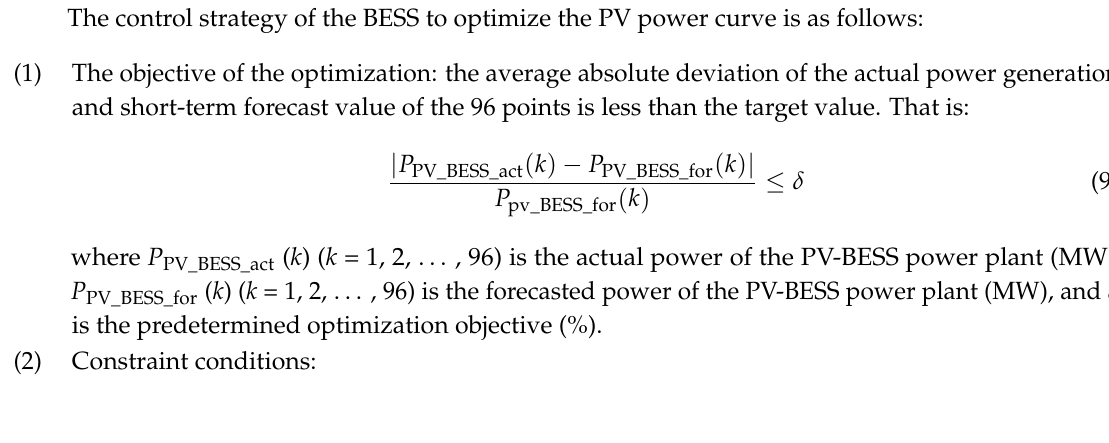
Figure 6. The schematic diagram of simulation.